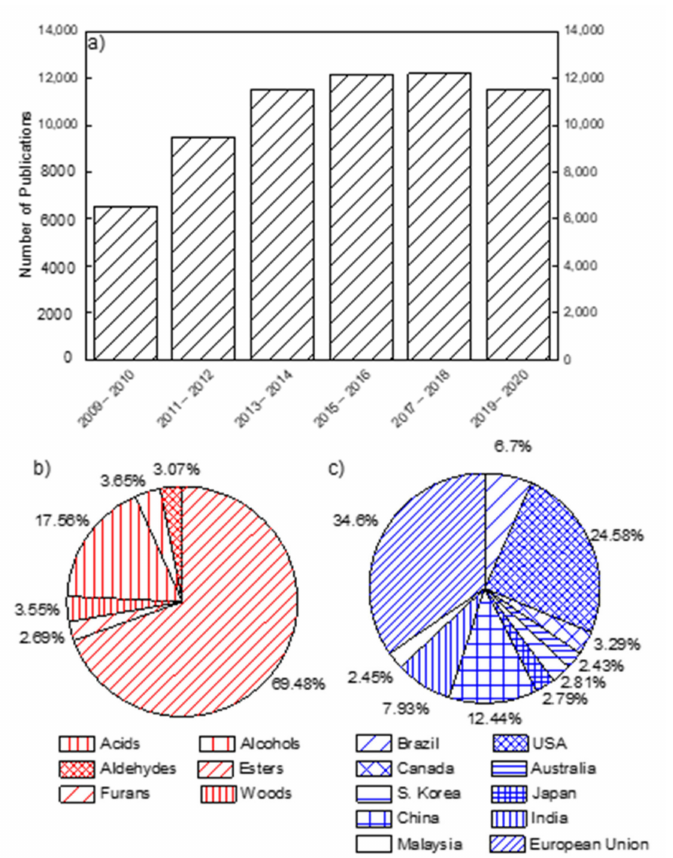
Figure 1. Global research trends of oxygenated biofuels for the last ten years ( a ), for the chemical classes ( b ), and countries ( c